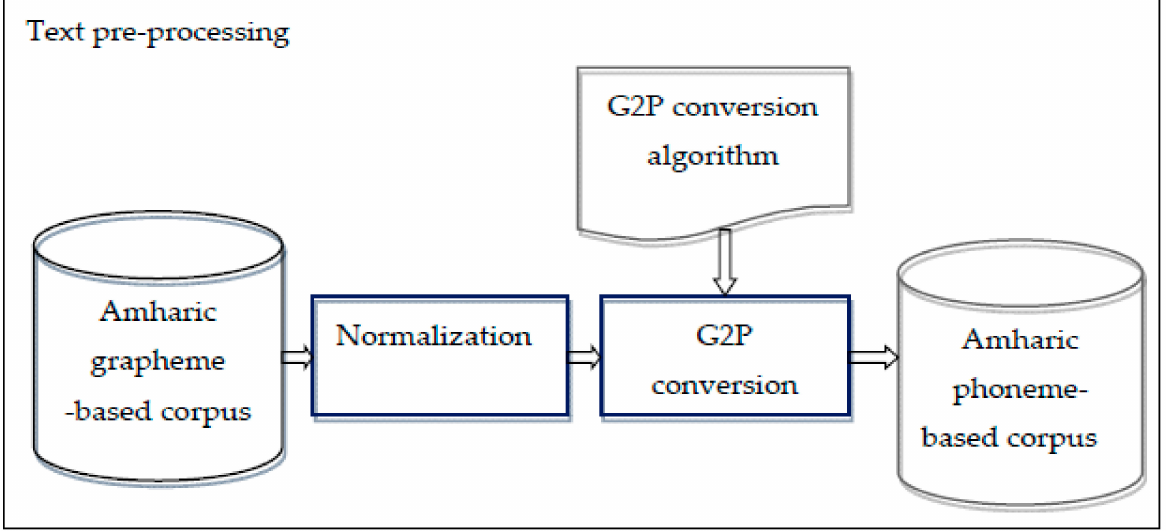
Figure 1. The overall text pre‑processing using a phoneme‑mapping